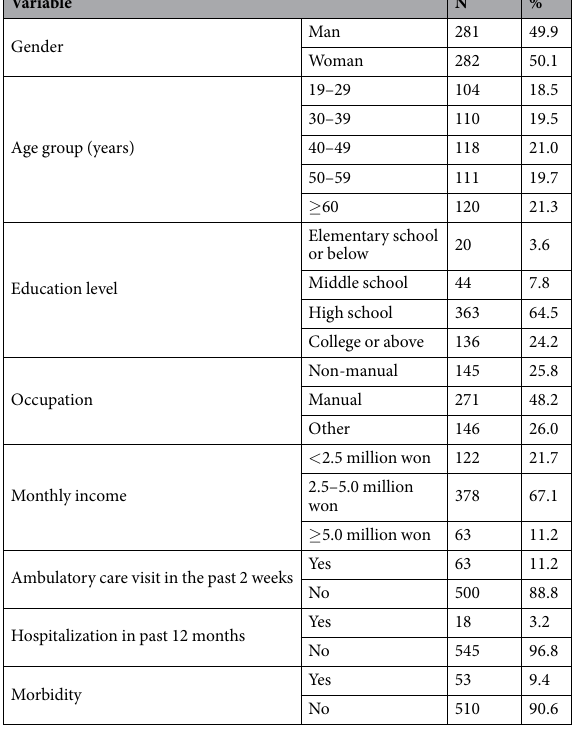
Table 1. General characteristics of the study